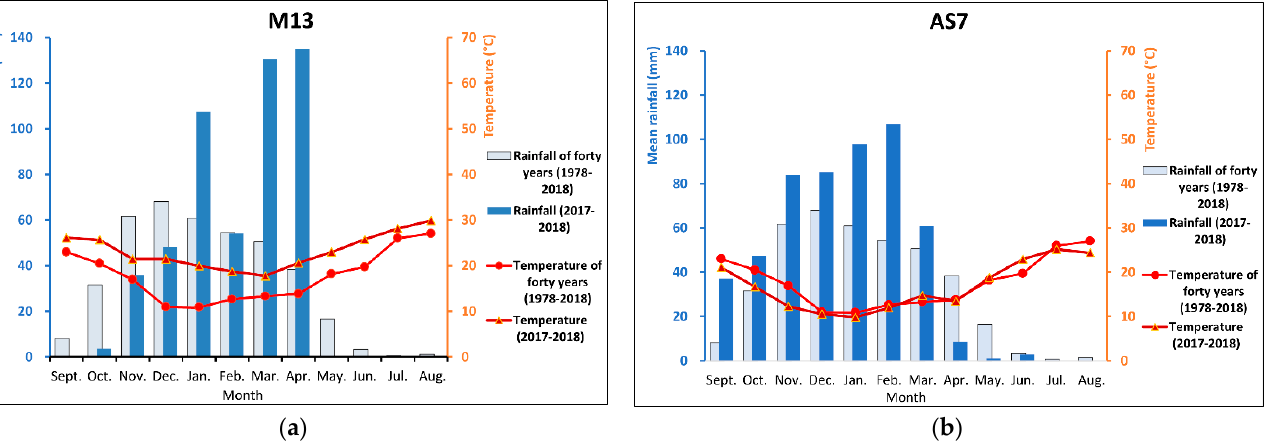
Figure 2. Precipitation and temperature of the Zaër region, recorded at the Marchouch experimental station and the Ain Sbit agricultural center during the 2017–2018 season compared to the 40-year average (1978–2018) for sites: ( a ) M13 and ( b ) AS7.